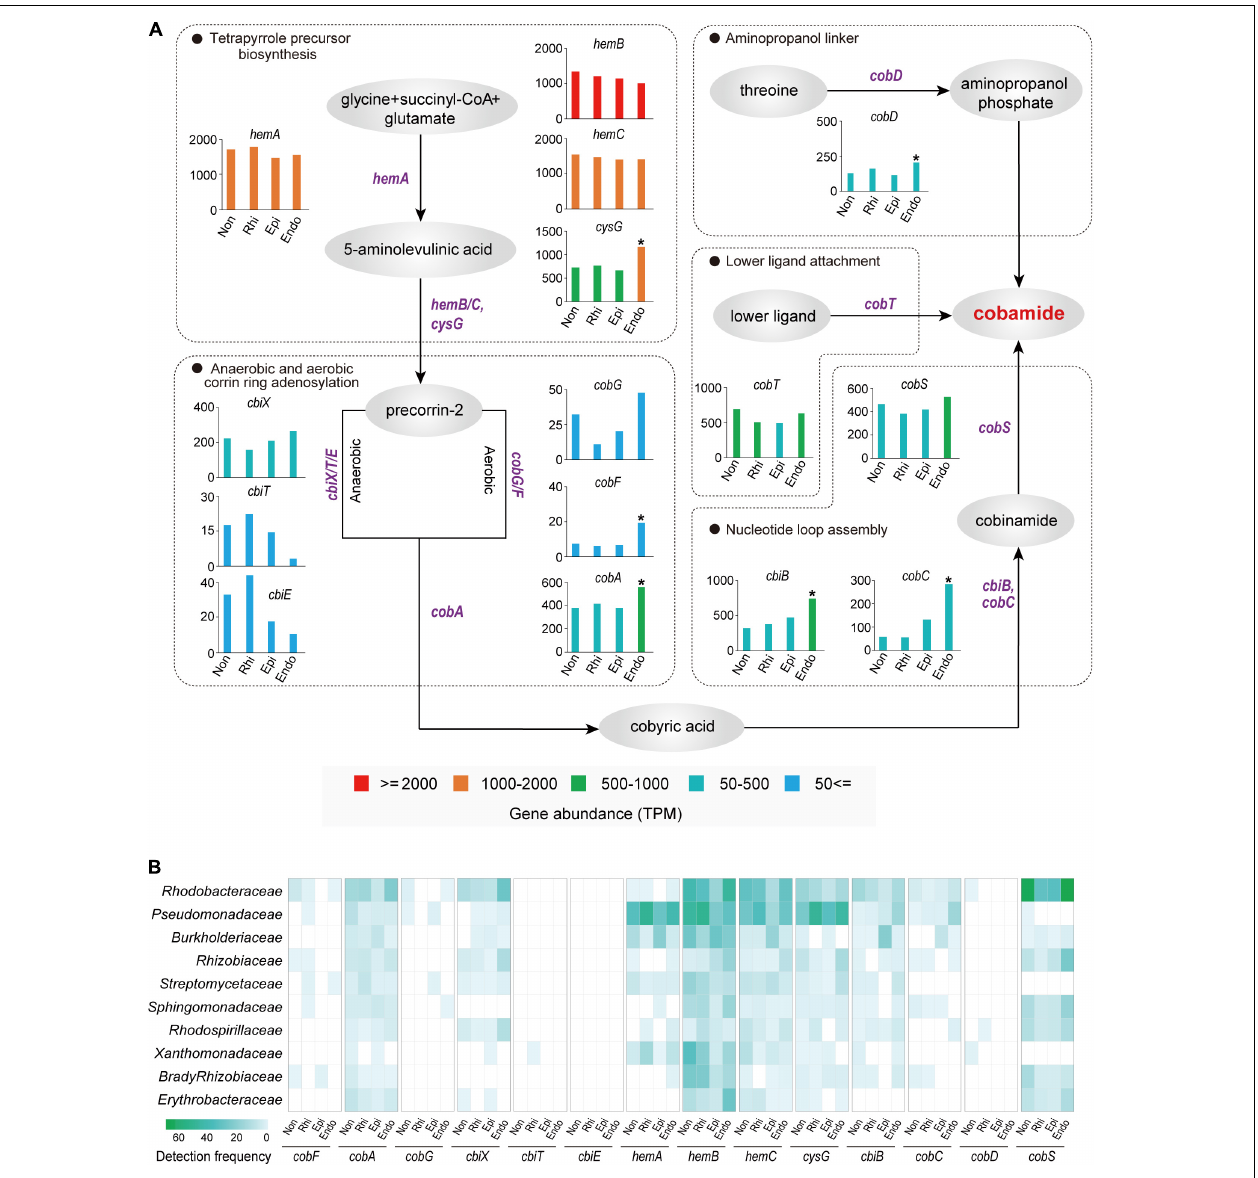
FIGURE 4 | Cobamide biosynthesis pathways and taxonomy profiles of cobamide biosynthesis microbiomes across the non-rhizosphere (Non), rhizosphere (Rhi), episphere (Epi), and endosphere (Endo) compartments. (A) Each substance is indicated by a gray oval, whereas each functional gene is labeled in purple. The significantly higher TPM (transcripts per-million) value of gene in the endosphere is indicated by an asterisk ( P < 0.05; two-tailed fisher exact test), compared to the three peripheral compartments. (B) Bacterial families with the top 10 highest detection frequency in cobamide biosynthesis genes are exhibited by a